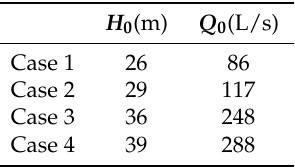
Table 3. Different demands of the heating, ventilation, and air-conditioning (HVAC)